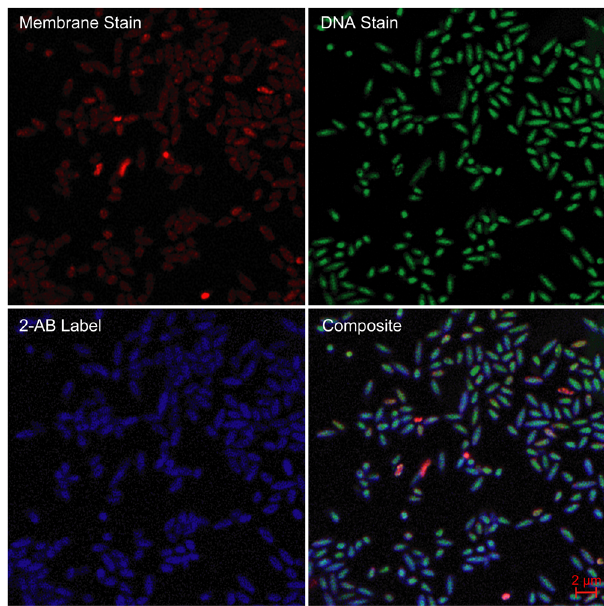
Fig. 7 Confocal microscopy of 2-AB-labelled cells recovered from B. cellulosilyticus grown on GH26-AcGGM after 1 h. Top right DNA view of cells stained with SYBR Green I. Top left Membrane view of cells stained with Bac Light Red. Bottom left View of cells labelled with 2-AB. Bottom right Composite view of all three channels.